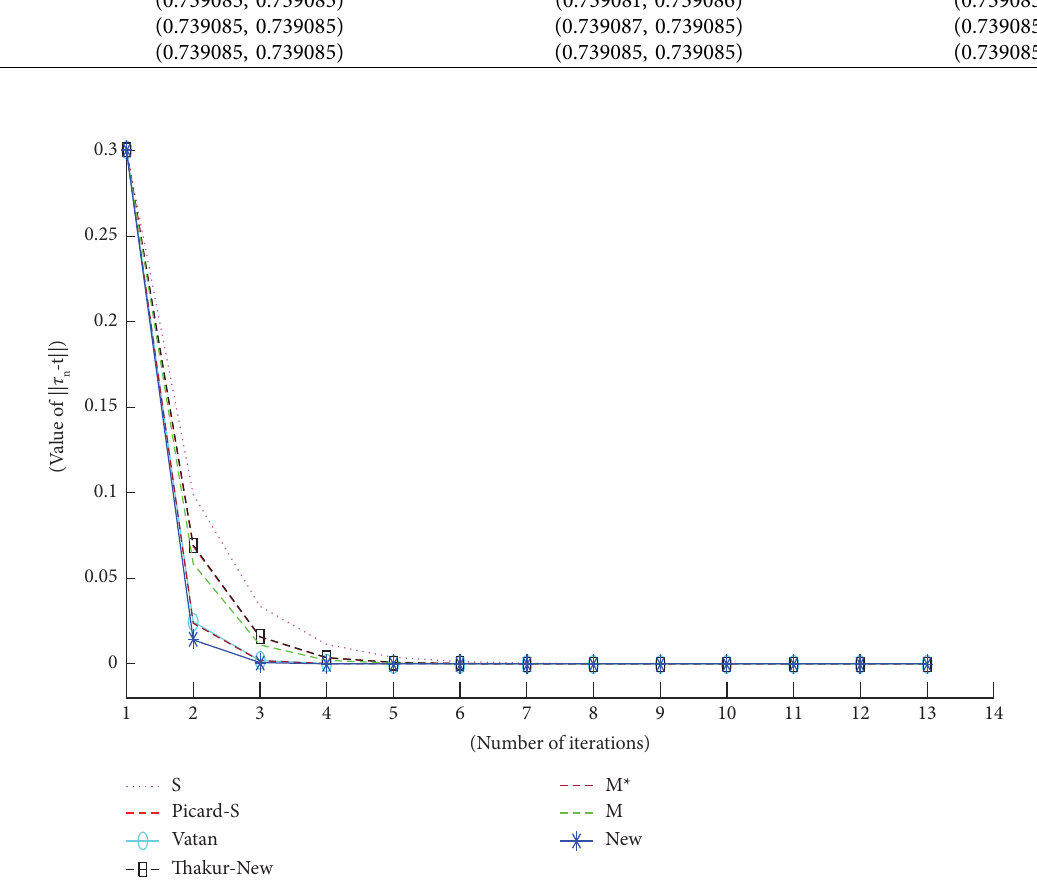
Figure 3: Comparison by the graph. Table 5: A comparison table for the rate of convergence of iterative methods for Example 2.